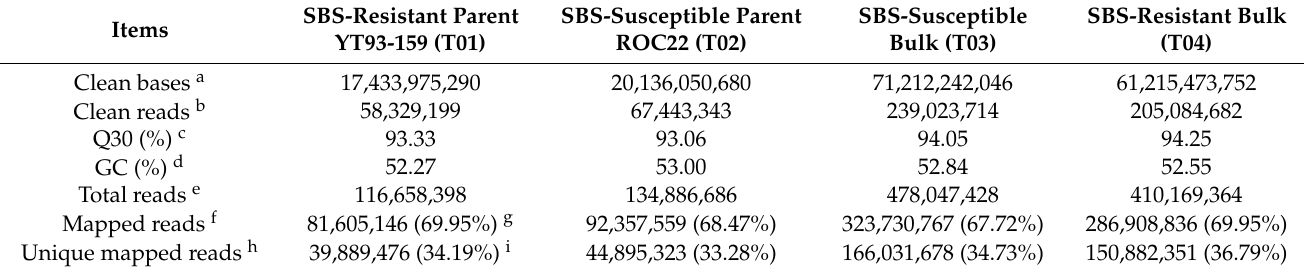
Table 1. Summary of BSR-seq of four